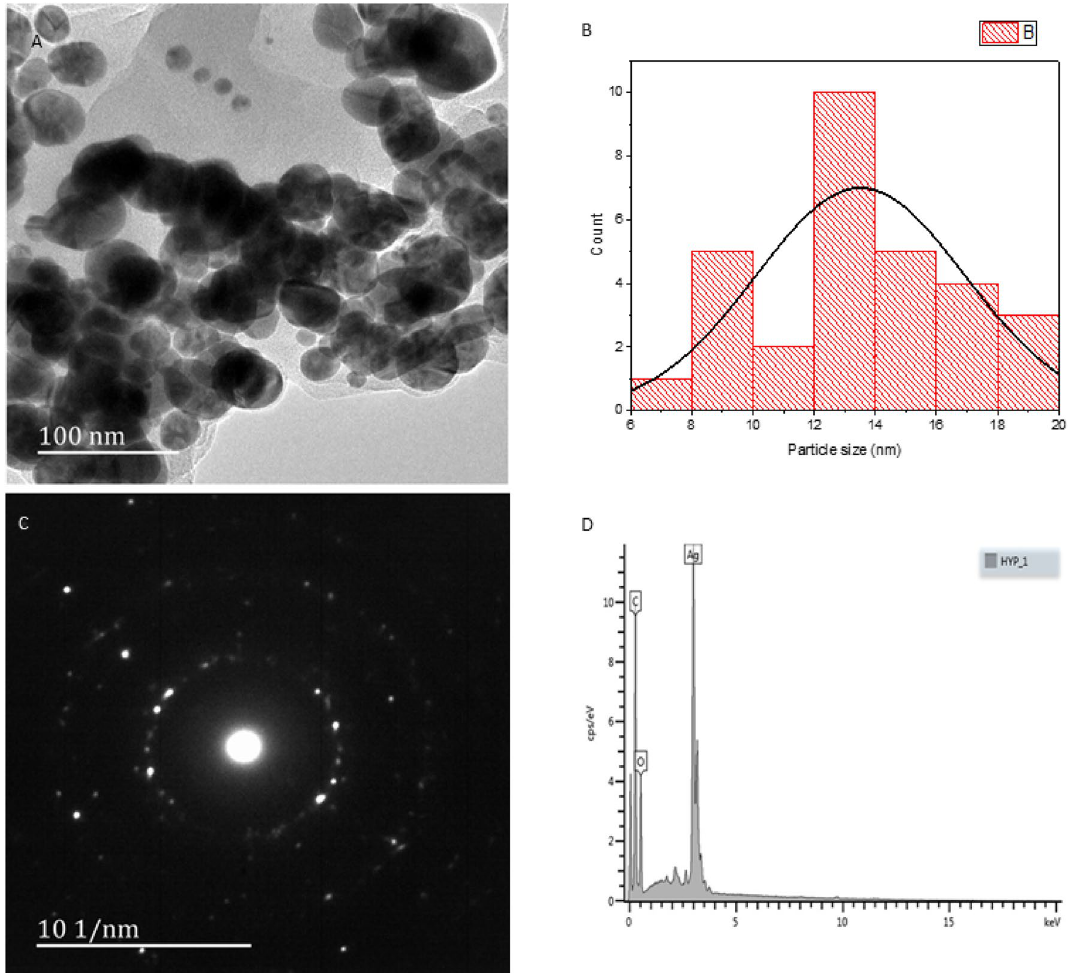
Figure 3. Morphology: ( A ) TEM, ( B ) Particle size distribution ( C ) TEM-SAED, ( D )